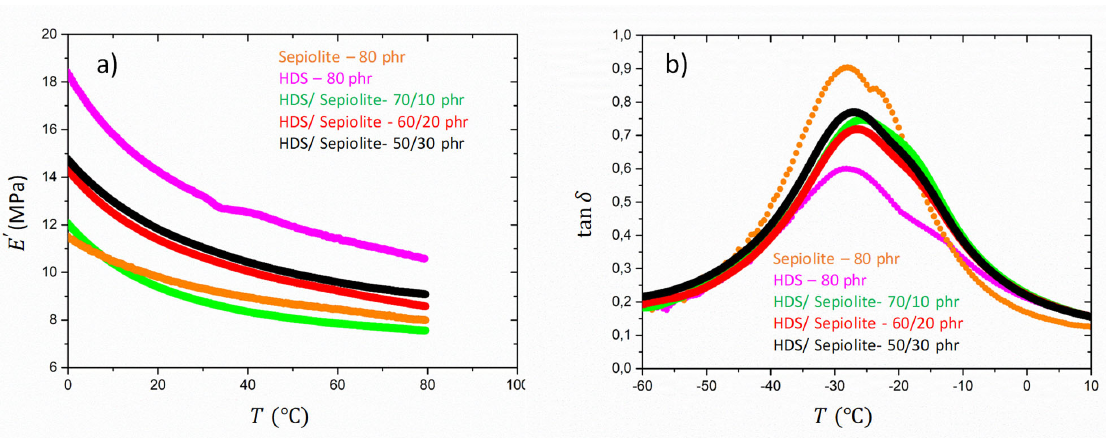
Figure 6. Plot of E (cid:48) ( a ) and tan δ ( b ) versus temperature for reference SBR samples and dual fillers Sepiolite/HDS-10/70 phr, Sepiolite/HDS ‐ 20/60 phr, Sepiolite/HDS ‐ 30/50 phr.